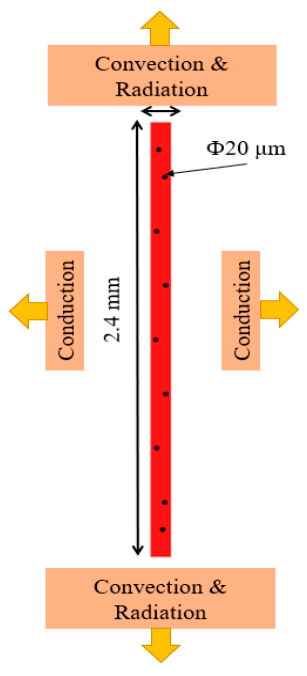
Figure 9. Geometric domain considered for simulation.